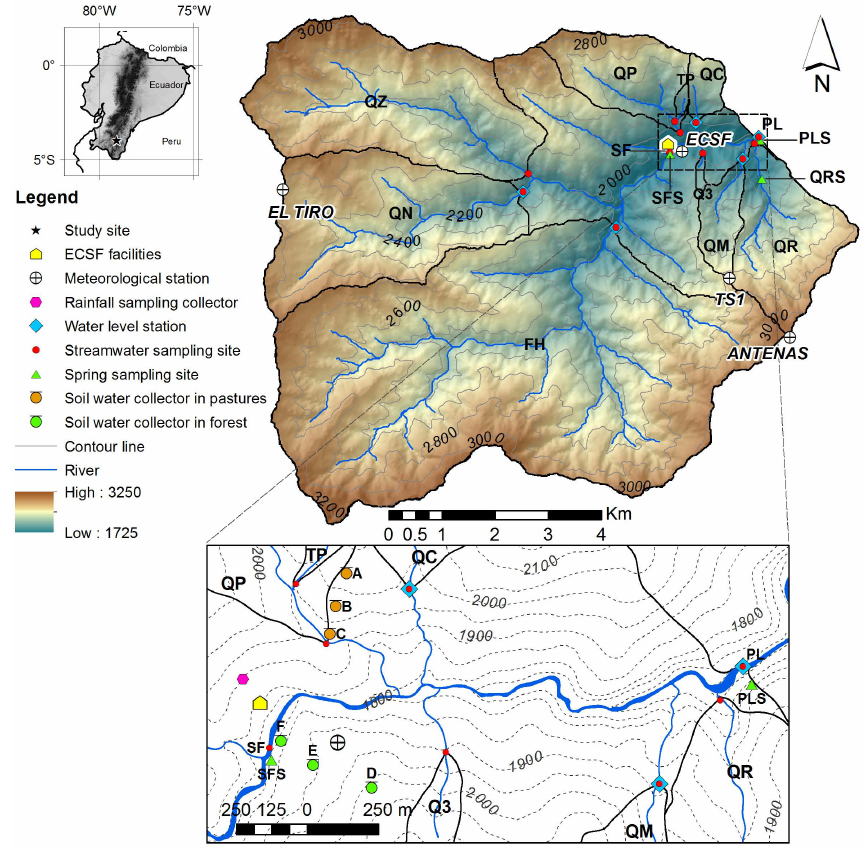
Fig. 1. San Francisco catchment with sampling locations and delineation of drainage area. Acronyms in bold are defined in Table 2. Framed image shows the zoomed area of the lower part of the